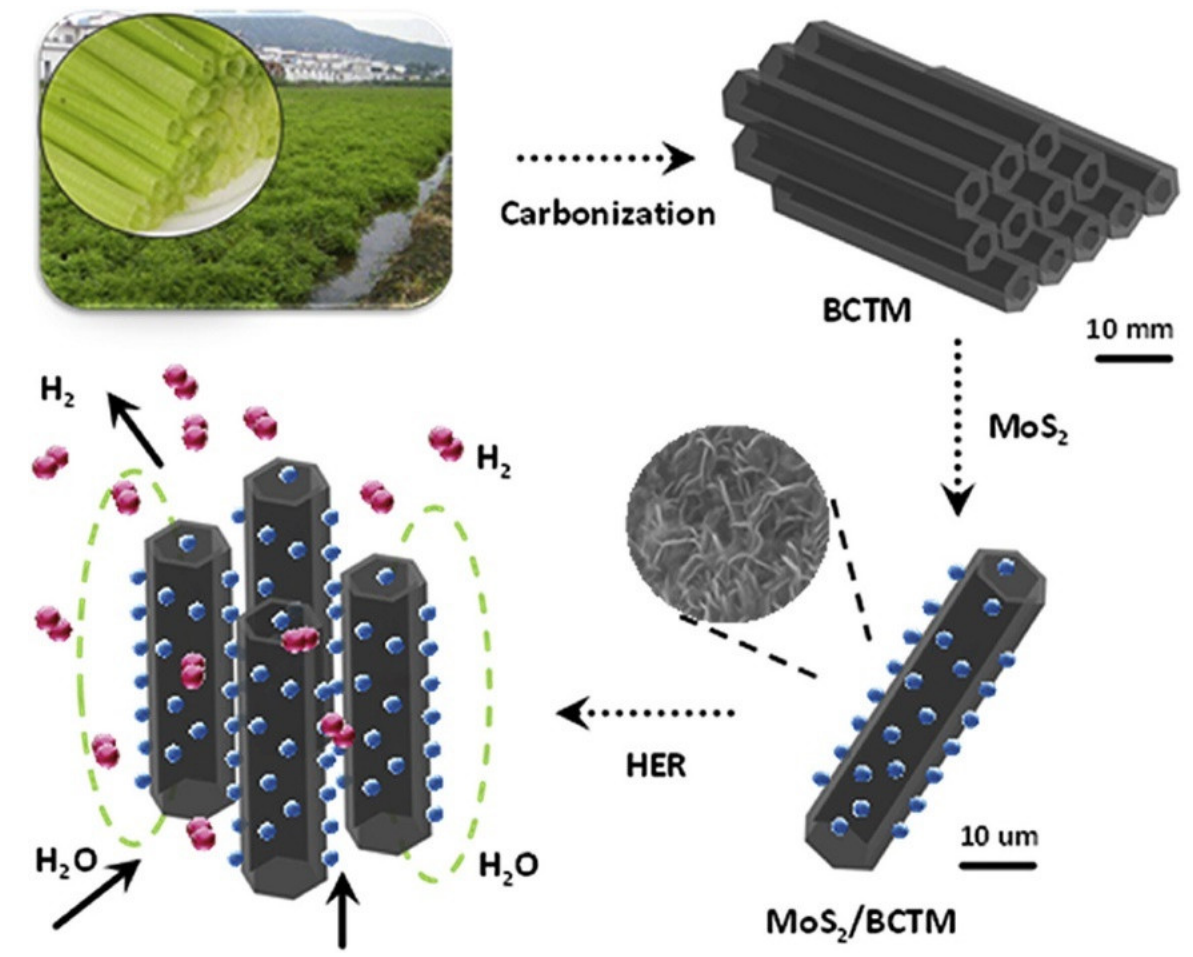
Figure 14. Preparation of MoS 2 /BCTM electrocatalyst and its application in HER. Reprinted from [156], Copyright (2019), with permission from Elsevier.